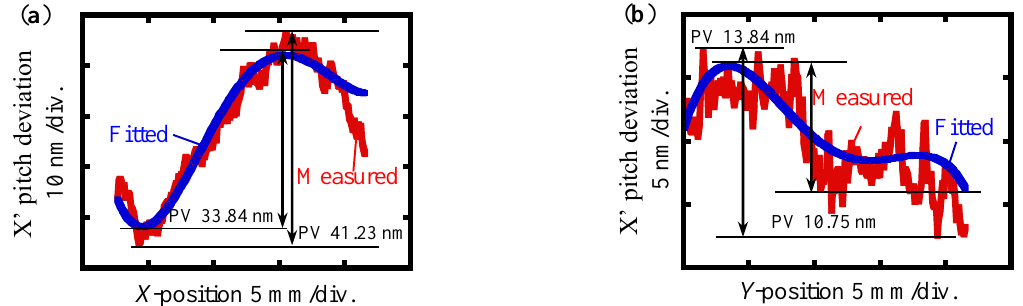
Figure 7. Measured and fitted results of the X ’ -directional pitch deviation. ( a ) Measured X ′ -directional pitch deviation ( b ) X ′ -directional pitch deviation fitted by a polynomial.